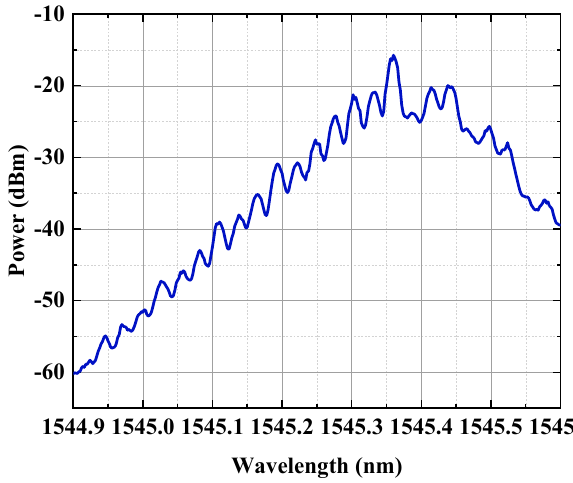
Figure 3. Optical spectrum of the microwave frequency divider.